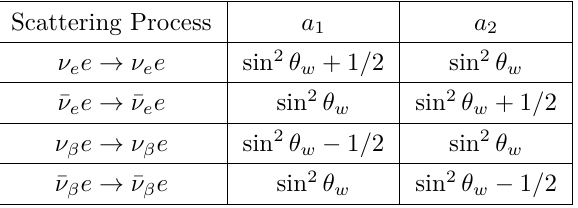
Table 2 . Values of a 1 and a 2 in terms of Weinberg angle ( θ W ) for different flavor of neutrinos (anti-neutrinos) and β corresponds to either µ or τ